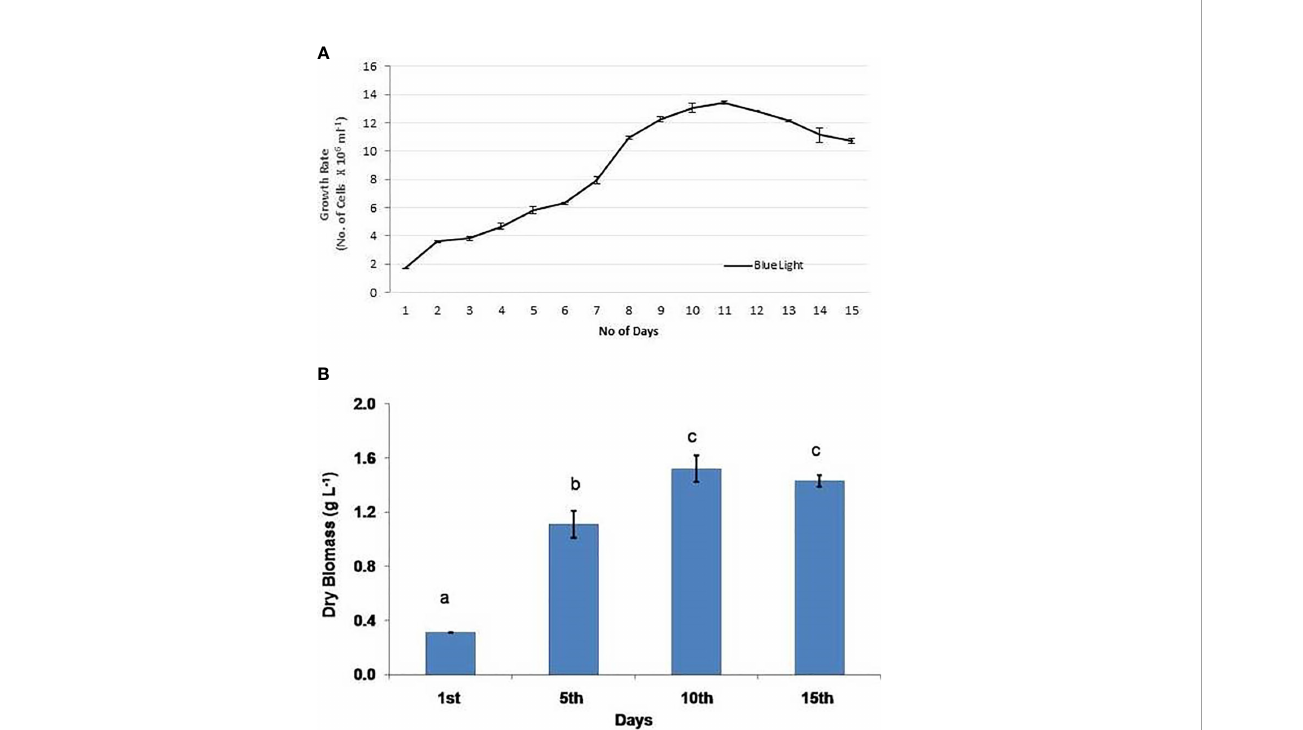
FIGURE 2 Combined experiment with optimized environmental variables: (A) cell growth and (B) biomass production. Experiments were conducted in triplicate and the values are expressed as mean ± S.E. The same letters (a, b, and c) indicate no signi fi cant difference between exposure groups at different exposure periods, whereas different letters indicate statistically signi fi cant differences (p < 0.05) between different exposure periods and